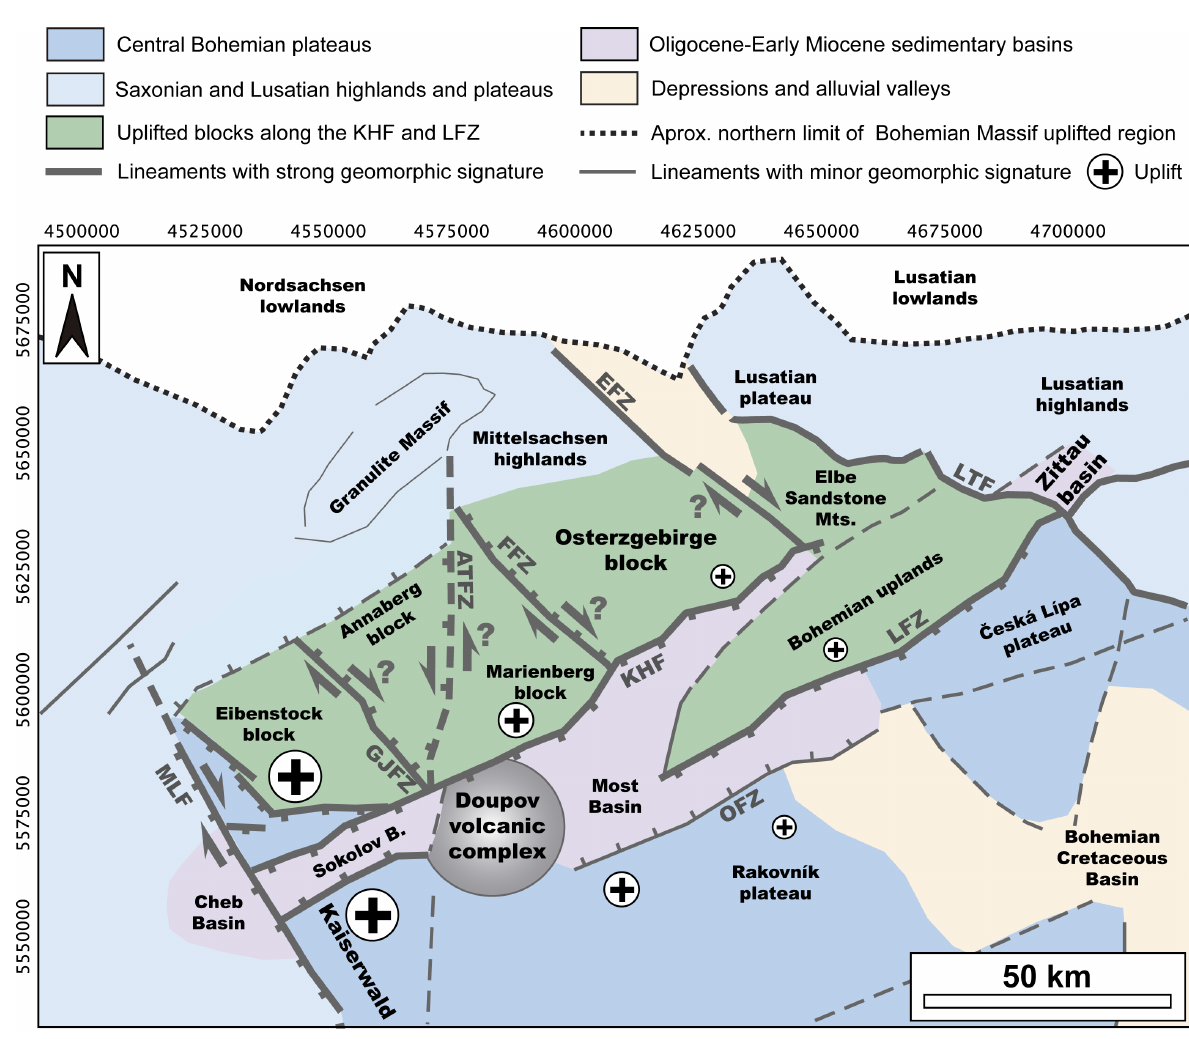
Figure 15. Interpretation of the recent morpho-tectonic framework based on the main discontinuities from geomorphic indices. Faults abbreviations: ATFZ, Annaberg-Teplá Fault Zone; EFZ, Elbe Fault Zone; FFZ, Flöha Fault Zone; GJFZ, Gera-Jáchymov Fault Zone; KHF, Krušné hory Fault; LFZ, Litomˇeˇrice Fault Zone; LTF, Lusatian Thrust Fault; MLF, Mariánské-Láznˇe Fault; OFZ, Ohˇre Fault